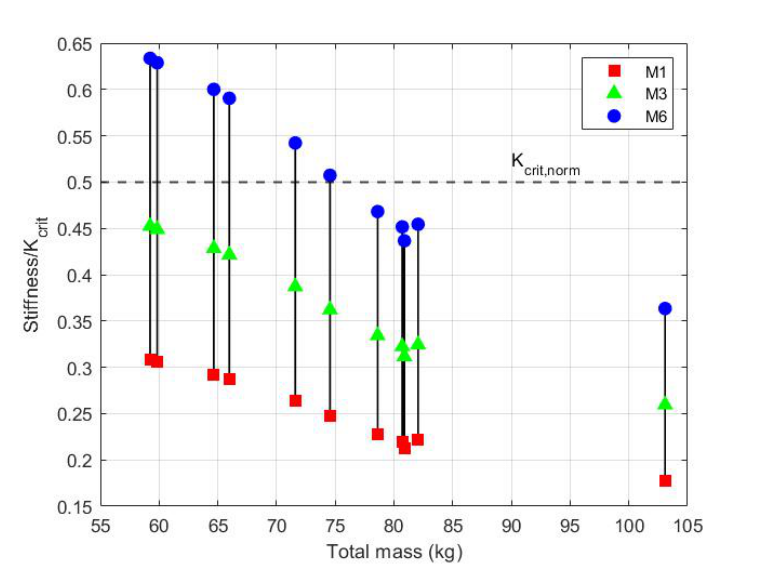
Figure 4. Ankle stiffness normalized by the critical stiffness K crit = m tot gh COM against the total mass of the subject (subject mass + prosthetic simulator mass).